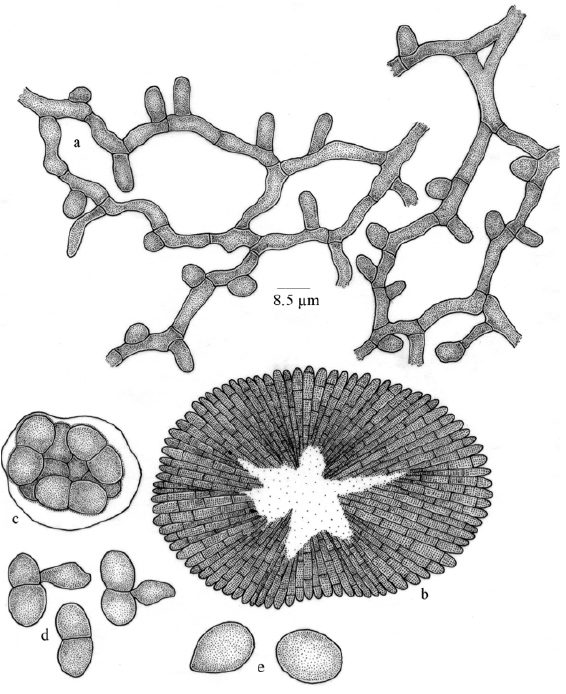
Figure 156. Asterina micheliifolia a.Appressorium, b. Thyriothecium, c. Ascus, d.